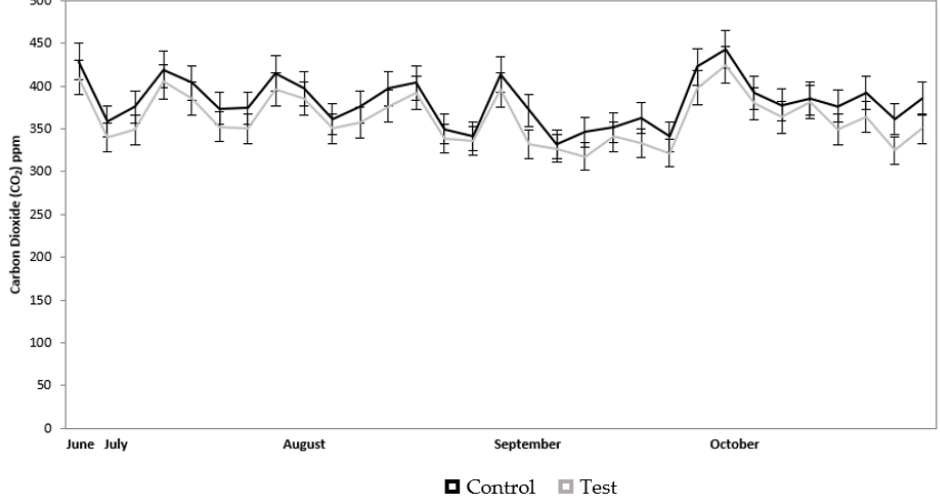
Figure 11. Daily average carbon dioxide (ppm) for test and control across all sites, June to October 2017.